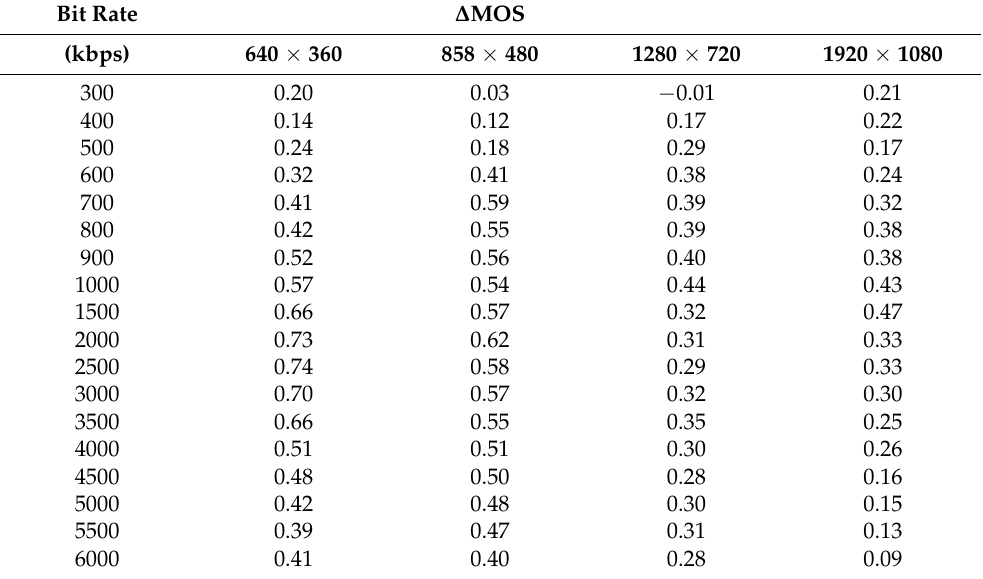
Table 9. Value of the difference in ∆ MOS (for VP9 codec) between the results obtained under laboratory and home